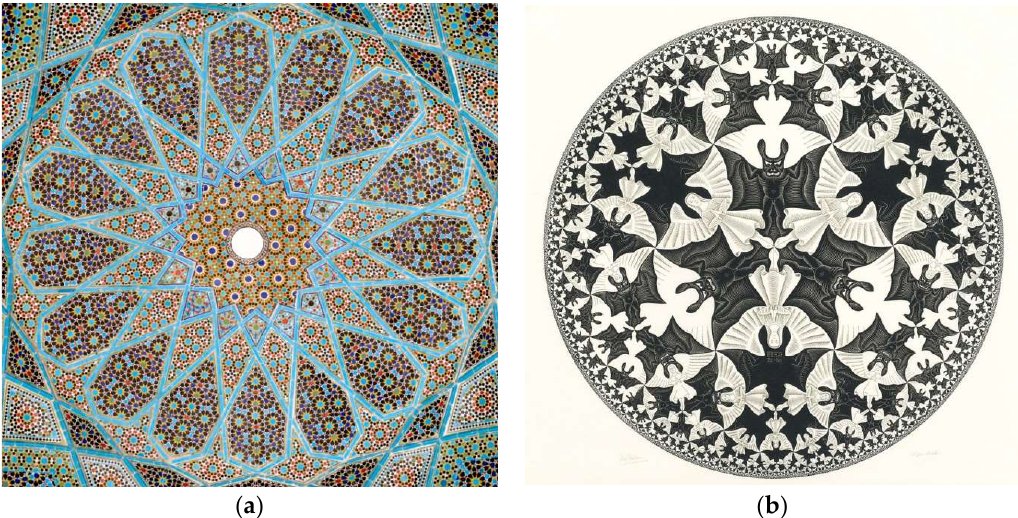
Figure 1. ( a ) Tomb of Hafez, Iran; ( b ) Escher, M.C. Himmel und Hölle ,